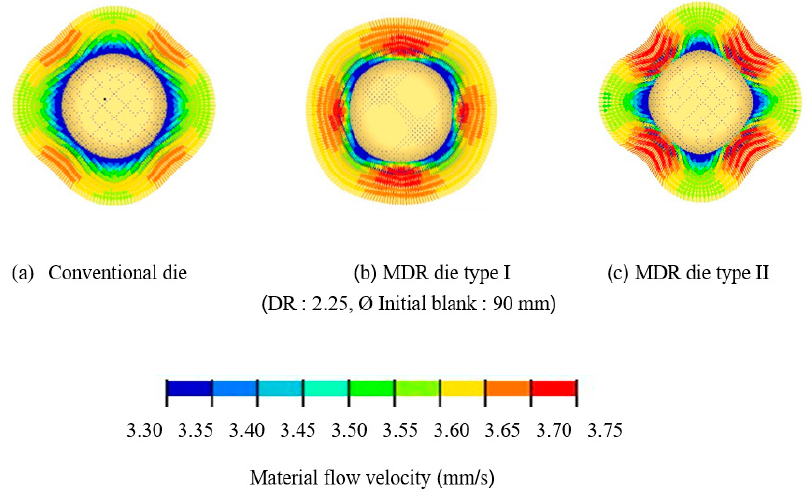
Figure 10. Material flow with respect to deep drawing dies: ( a ) Conventional die; ( b ) MDR die type I; ( c ) MDR die type II.